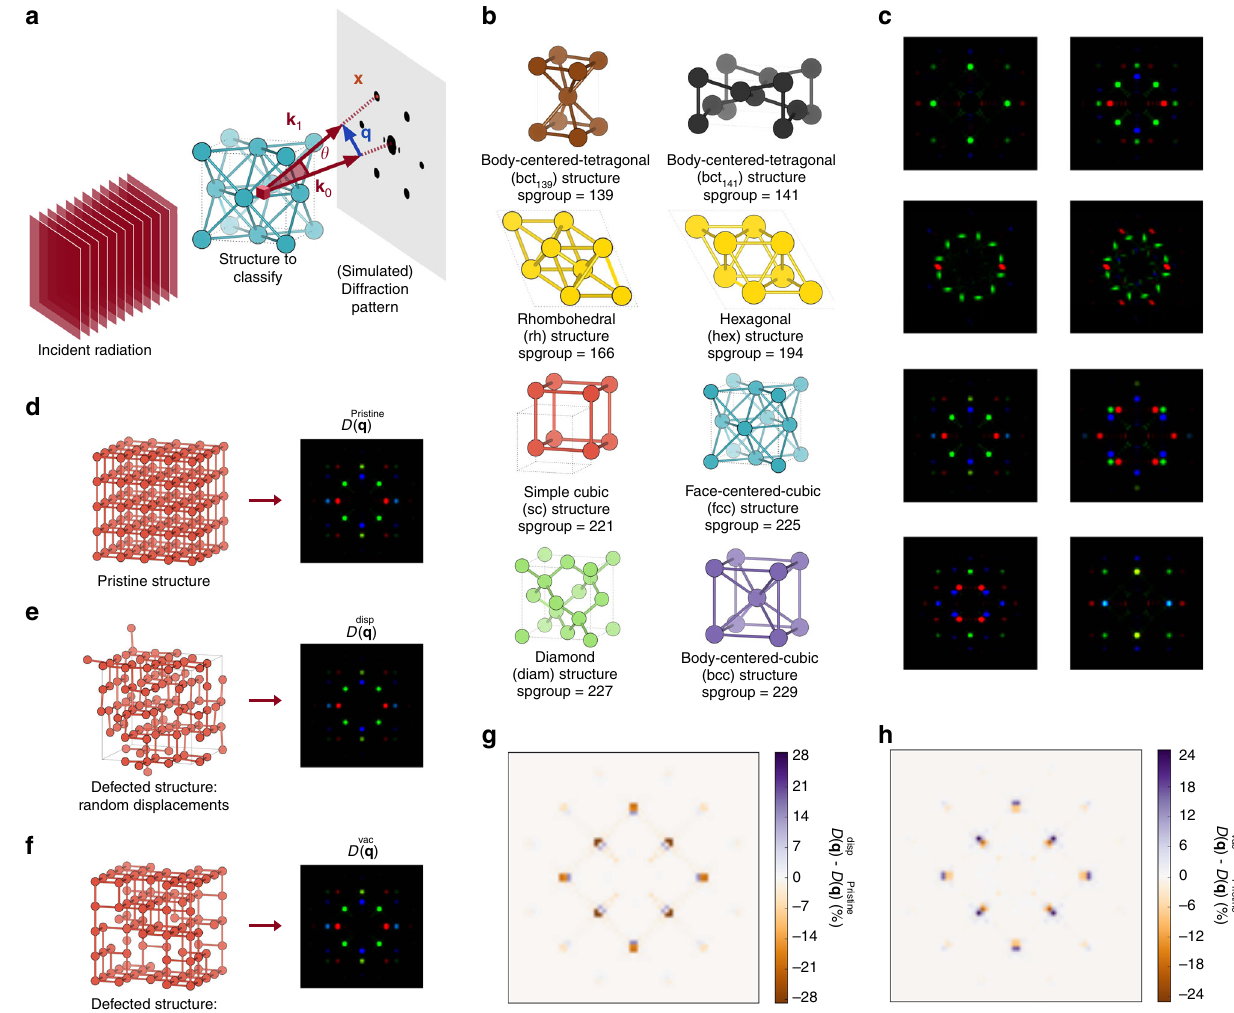
Fig. 2 The two-dimensional diffraction fi ngerprint. a Schematic representation of the two-dimensional diffraction fi ngerprint calculation. An incident plane wave is scattered by the material, and the diffraction pattern on a plane perpendicular to the incident radiation is computed. b Prototypes of the crystal classes considered in this work. c Examples of two-dimensional diffraction patterns for materials belonging to each of the eight classes. The ordering is the same as b . Rhombohedral and hexagonal structures have the same two-dimensional diffraction fi ngerprint. d – f A pristine simple cubic structure ( d ), the same structure with 25% of vacancies ( e ), and with atoms displaced randomly according to a Gaussian distribution with standard deviation of 0.08 Å ( f ), together with their diffraction fi ngerprints. g , h Difference between the diffraction fi ngerprints of the defective ( e ), ( f ) and the pristine structure ( d